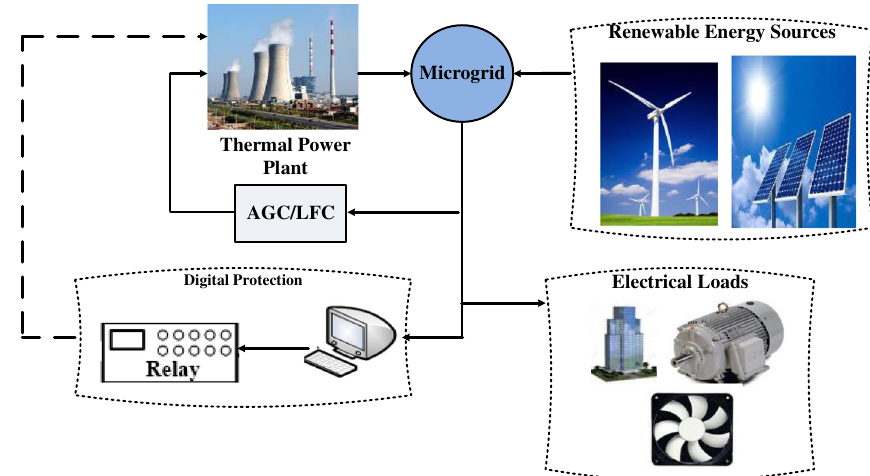
Fig. 2 The studied model of the islanded microgrid with the coordination strategy